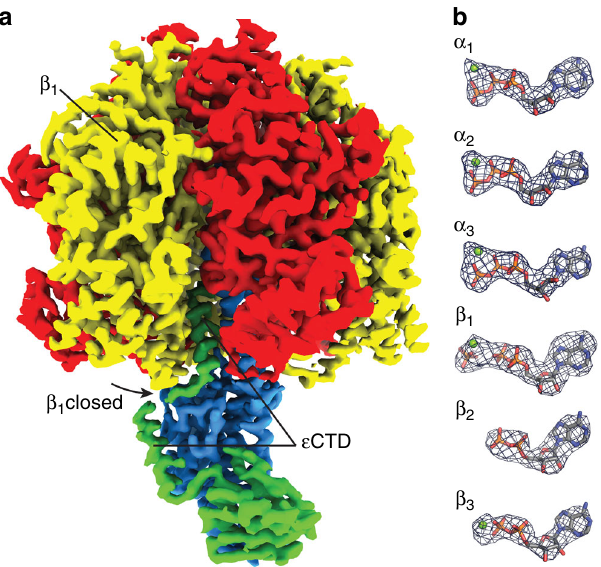
Fig. 6 The F 1 motor changes conformation to the autoinhibited state in 10 mM MgADP. a Masked maps of the α , β , γ , and ε subunits showing the β “ half-closed ” (black arrow describes direction of 1 subunit (labeled) movement in β 1 subunit) onto the ε CTD (labeled). The C-terminal domain of the ε subunit is in an “ up ” conformation. b Nucleotide and Mg 2 + occupancy of the α and β subunits, with difference density (blue mesh) of nucleotides shown (with equivalent Mitochondrial F 1 nomenclature 4 : β 1 = β β = β β = β 25 DP , 2 E , 3 TP